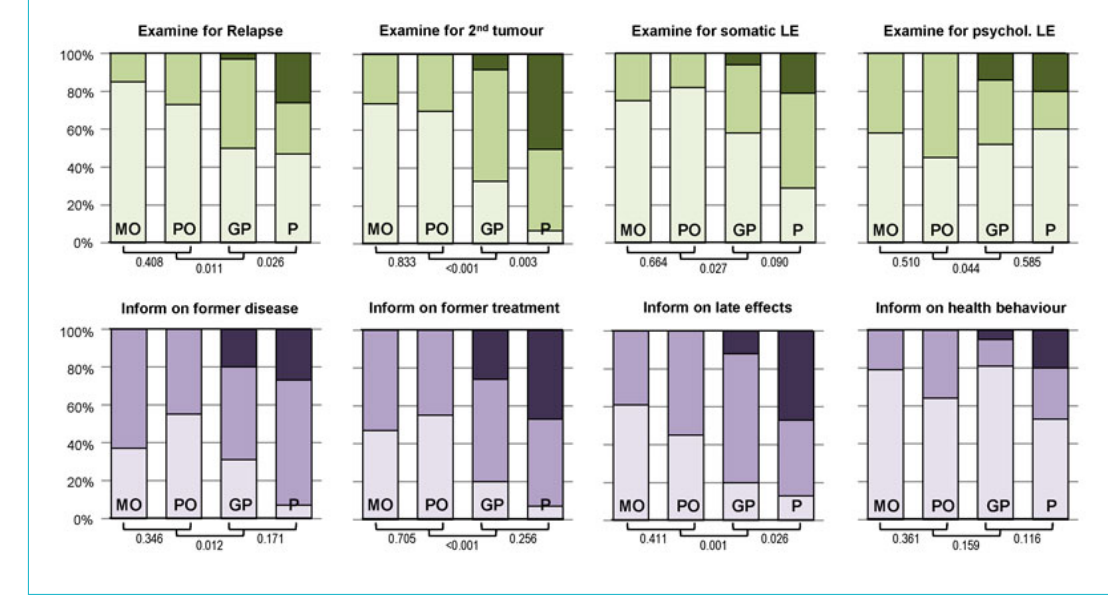
Figure 2: Content of follow-up care provided by different medical specialists.The figure bars represent the proportion of physicians who pro- vide the respective service within follow-up care, stratified by medical specialisation. The numbers below the bars indicate p-values from chi- square statistics comparing medical specialists: medical oncologists vs paediatric oncologists; general practitioners vs paediatricians; and both oncologist combined vs both generalist combined.Light colour = “yes, all patients”; medium colour = “yes, if necessary”; dark colour = “no”GP = general practitioners; LE = late effects; MO = medical oncologists; PO = paediatric oncologists; P = paediatricians; psychol. =